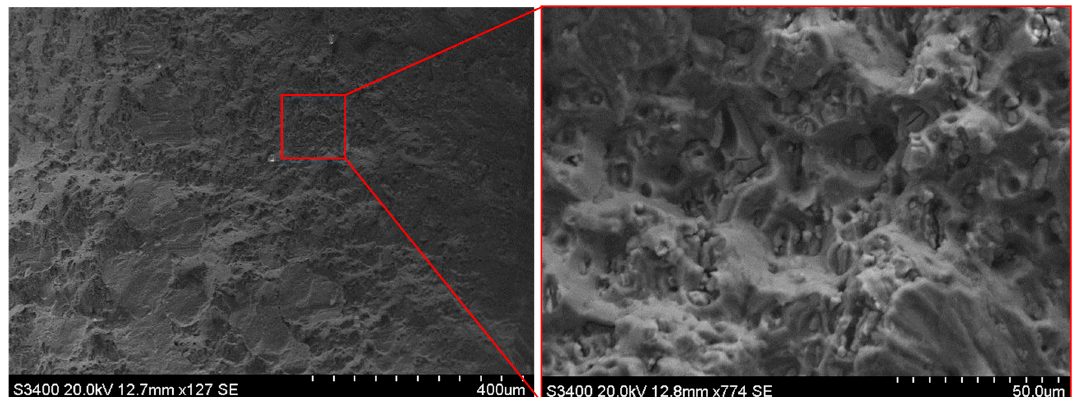
Figure 7. The scanning electronic micrograph of the adhesively bonded composite joint’s fracture surface.